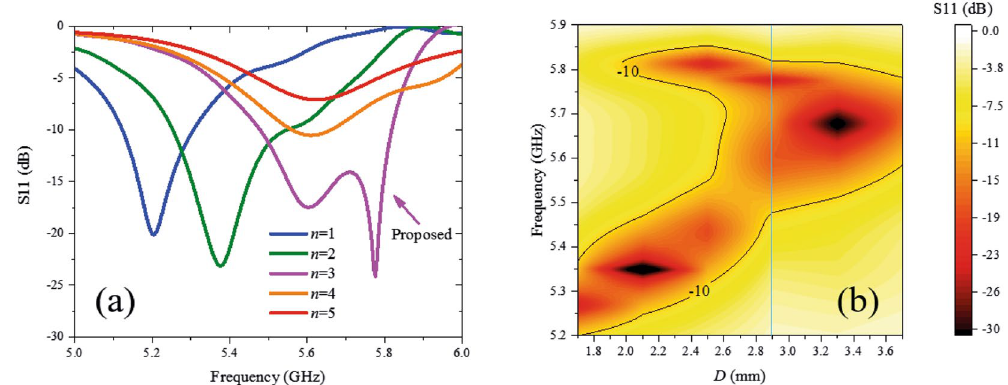
Figure 5. Relations between structure parameters and reflection coefficients. ( a ) Reflection coefficient versus the number n of side additional grounded holes. When n increases from 1 to 3, the resonant point of TM14 mode appears gradually; when n further increases from 3 to 5, the resonant depth decreases gradually. ( b ) Reflection coefficients versus different feed positions. With increasing distance D between feed position and grounded holes, two resonant points in the map gradually get closer. When D = 2.9 mm, a relatively wide operational frequency band is obtained, as the vertical line